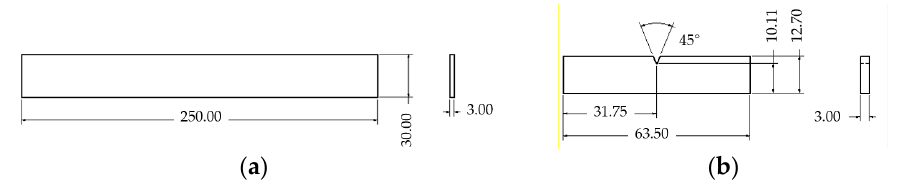
Figure 4. Dimension and shape of samples. ( a ) Tensile test and ( b) impact test.